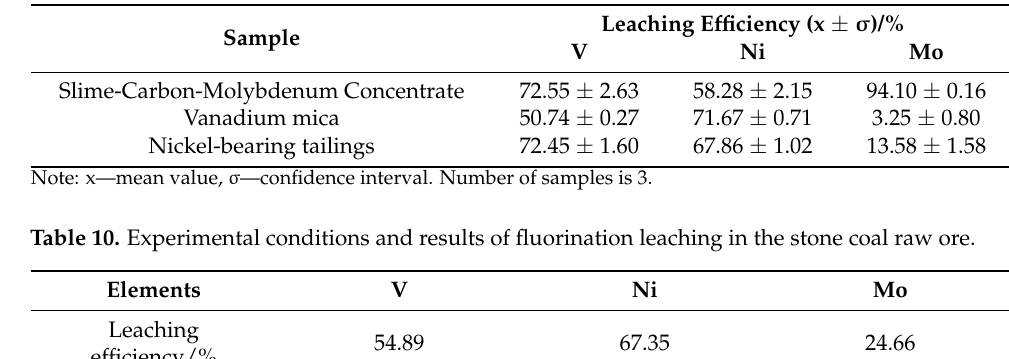
Table 9. Leaching efficiency of different beneficiation products.